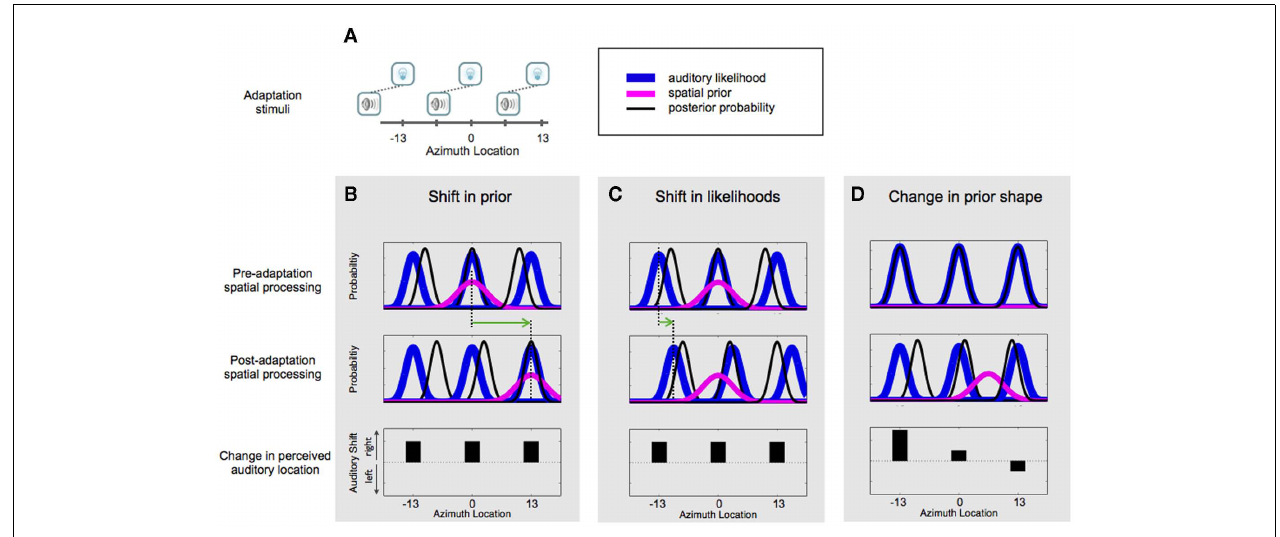
the prior distribution is shifted to the right.The broken lines and green arrow highlight the shift in the prior distribution.The bottom panel shows the change in auditory spatial estimates (the max of posterior) after exposure (i.e., post-pre in the peaks of the black curves). Positive values denote a shift to the right. In scenario depicted in (C) , adaptation causes a shift in likelihoods (blue curves).This mechanism produces the same behavioral effect as shown in (B) as seen in the bottom panel. Note that a smaller shift in likelihood (highlighted by the green arrow) results in the same magnitude of aftereffect as a larger shift in prior due to the relative widths of the distributions. In the scenario depicted in (D) , before exposure the prior distribution is relatively flat (i.e., there is no bias for location), and after exposure a bias for a location to the right appears.This creates an asymmetrical pattern in aftereffect magnitudes across